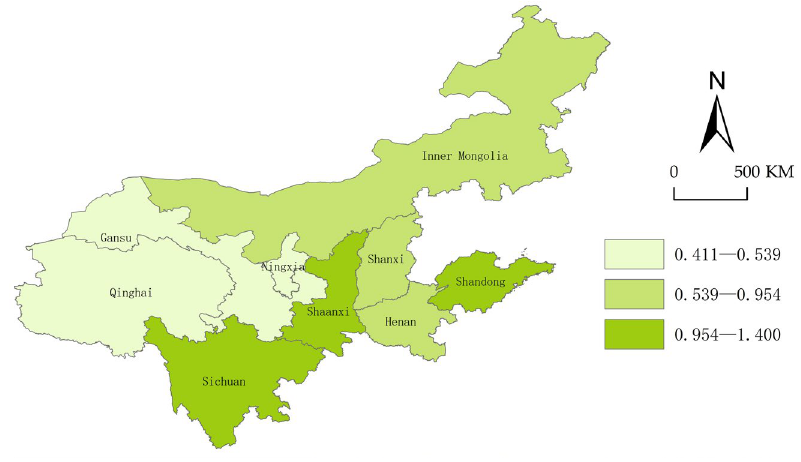
Figure 7. Security landscape of the Yellow River Basin (2019).